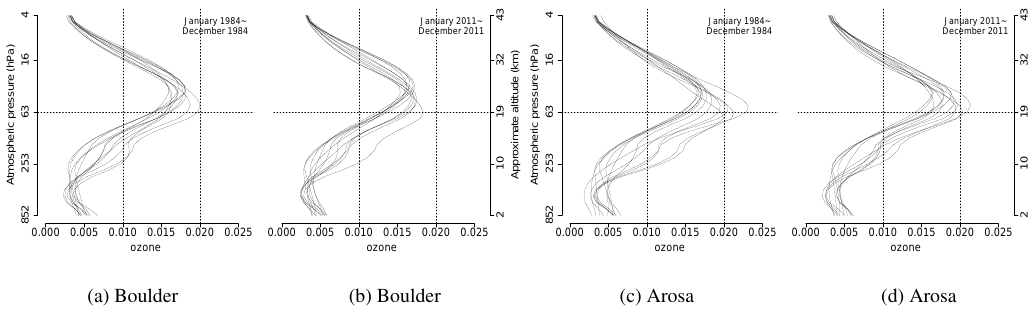
Fig. 1. Smoothed monthly ozone values (profiles) in DU (scaled by 1000) from two locations (Boulder and Arosa), based on the method of smoothing splines for selected years of 1984 and 2011. The ozone profiles are represented as a function of altitude in km, or equivalently of atmospheric pressure in hPa. In each panel, vertical lines are drawn at 0.01 and 0.02. Horizontal lines are drawn at 63hPa, which is approximately equivalent to 19km in altitude.